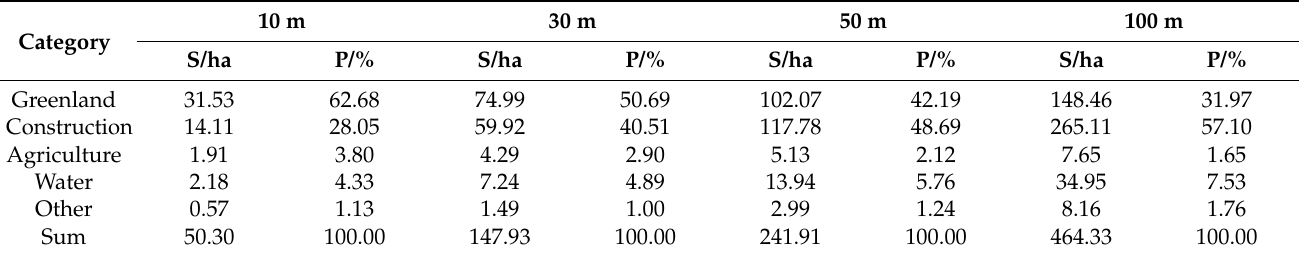
Table 4. Composition of the land class with different buffer zone distances for corridors with recreational potential.